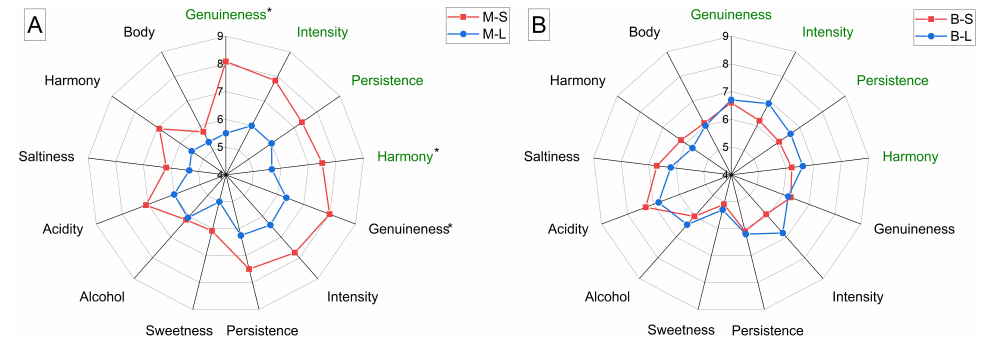
Figure 3. Radar graphs showing the results of the sensory evaluation of the wines produced from different combinations of grape cultivars (M—Minutolo, B—Bombino) and yeast starters (S— Saccharomyces cerevisiae , L— Lachancea thermotolerans ). Minutolo ( A ) and Bombino ( B ) wines fer- mented with different yeasts. Odor descriptors are in green, taste/flavor descriptors are in black. For each parameter, significant differences between yeast starters are indicated with an asterisk ( p <